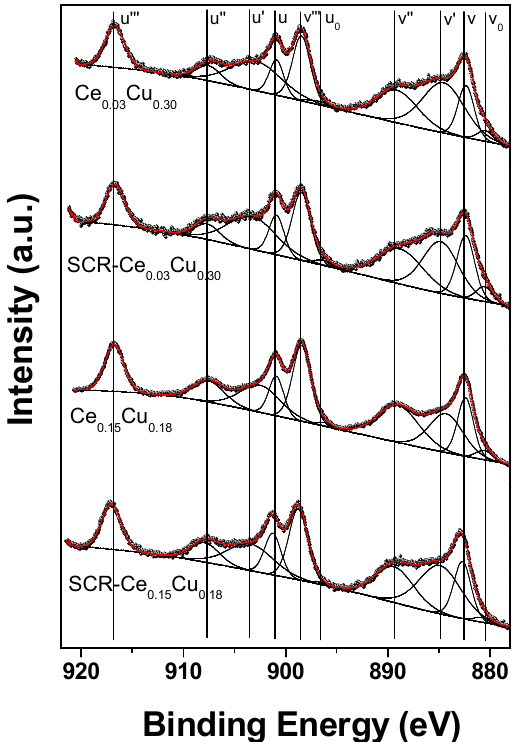
Figure 8. Ce 3d XPS spectra of Cu–Al spinels doped with cerium for fresh and used catalysts.